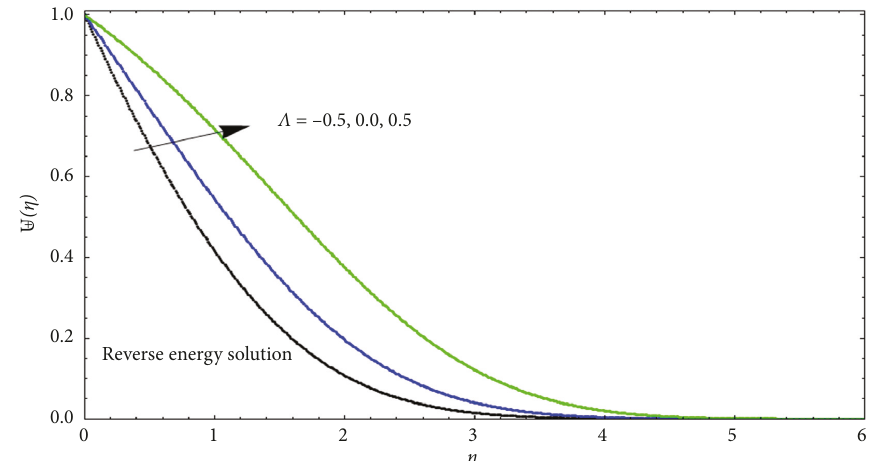
Figure 9: Dissimilarity of ⊎ ( η ) being some different values of Λ and Pr � 1 for only RFS.